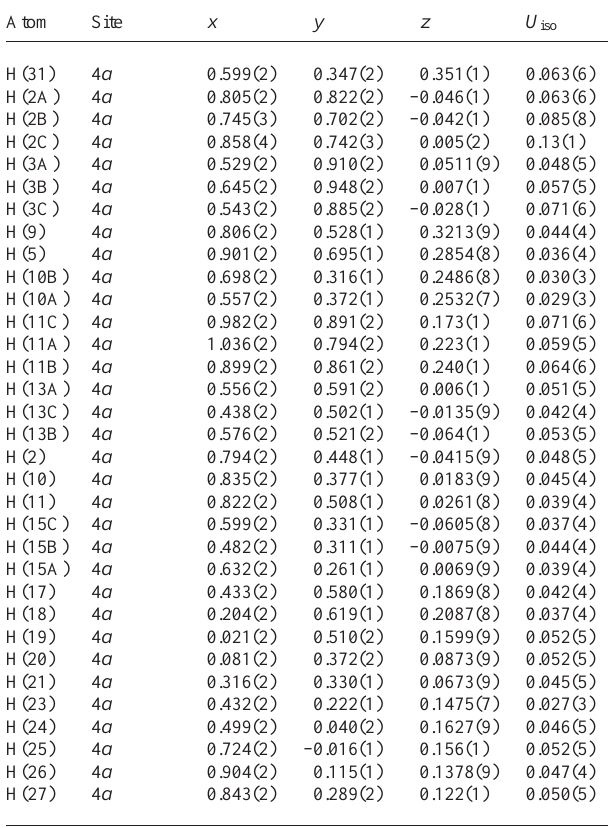
Table 2. Atomic coordinates and displacement parameters (in Å 2 )